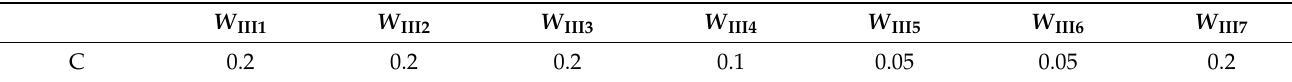
Table 2. Table of valuation parameter weight